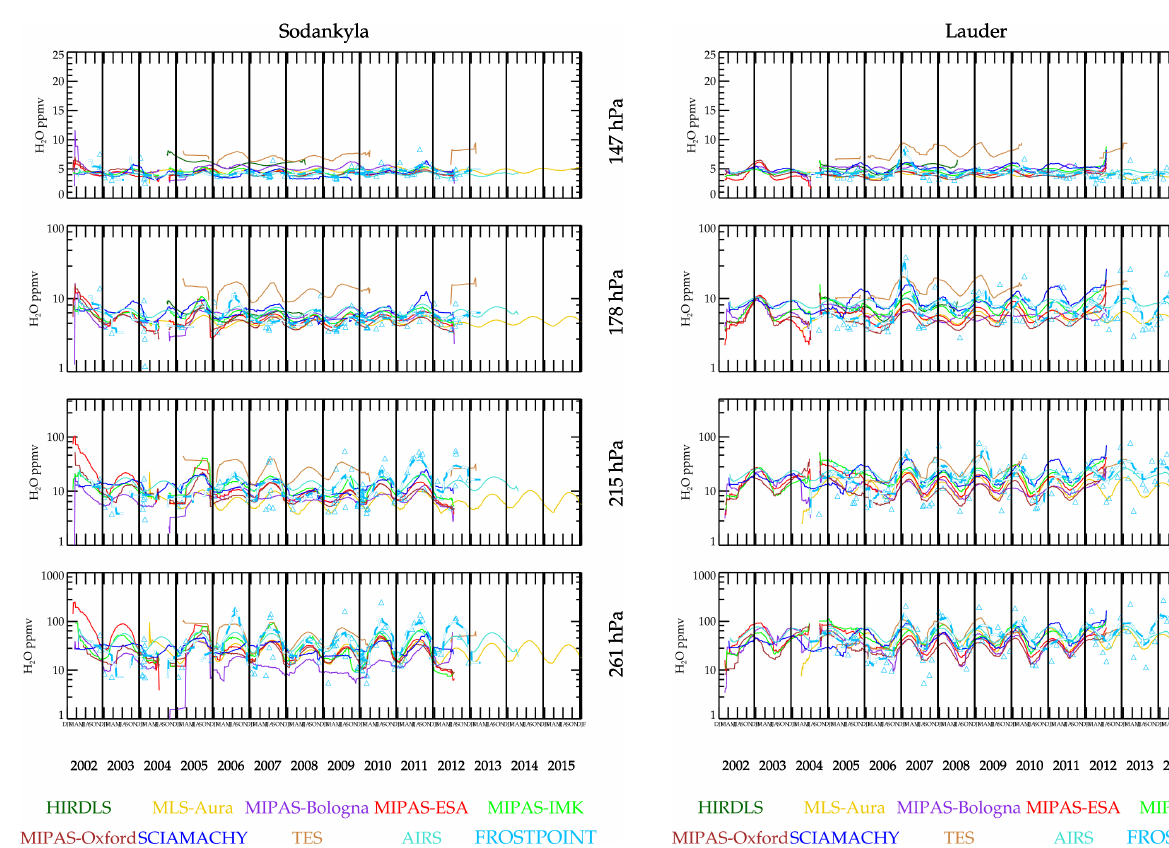
Figure 9. Same as Fig. 7 but for Sodankylä, Finland. Figure 10. Same as Fig. 7 but for Lauder, New